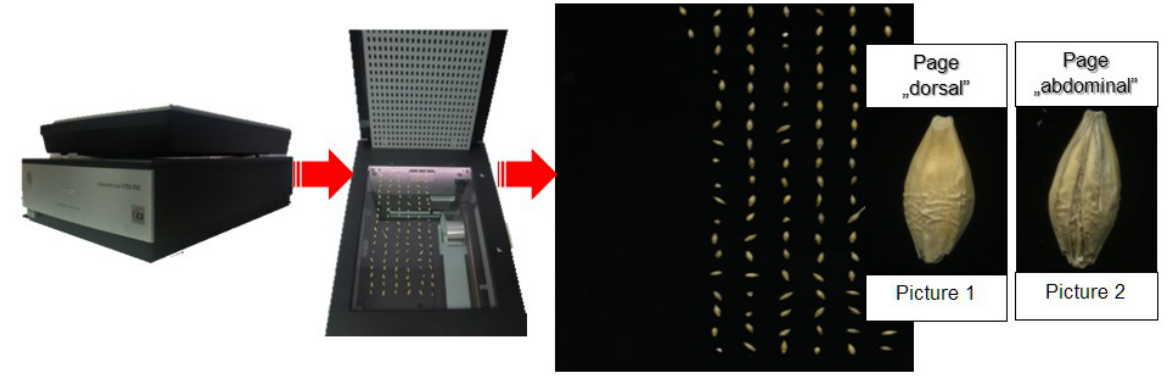
Figure 2. The process of acquiring digital images of kernels: “dorsal” and “ventral” side. A total of 176 digital images of malting barley kernels of the cultivar Sebastian were acquired. For the processing and analysis of digital images of kernels, the original IT system “ Hordeum v.3.2” (see Figure 3) was developed, which is not only dedicated to image processing and analysis but is also a useful tool for the generation of the teaching files for ANN. For the design and construction of the above-mentioned application, GUI (graphical user interface) was used as a standard implemented in the MATLAB 2014b environment (Figure 3). Elements of the Statistica v. 10 statistical package were used to create a neural compressor of graphic empirical data. The standard procedure implemented in the reduction” module by StatSoft, described in the Section 2.2 (pages: 7 and 8), was